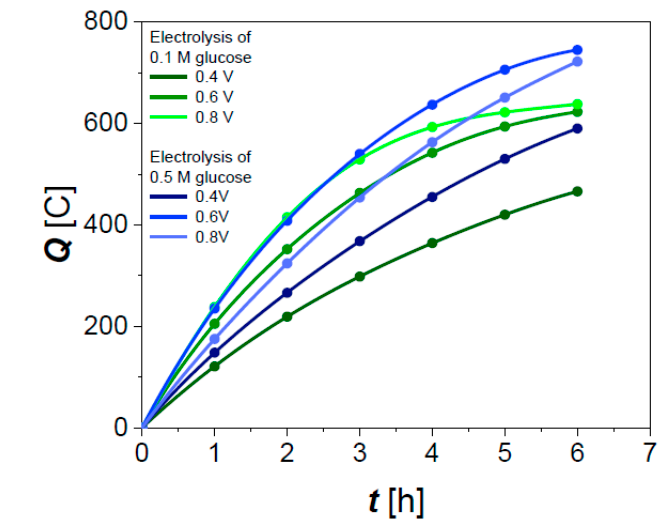
Figure 6. Coulombic charge versus time ( Q ( t )) curves from chronoamperometry measurements of 0.10 mol L − 1 glucose electro-reforming in 0.10 mol L − 1 NaOH solution at +0.4 V, +0.6 V and +0.8 V.